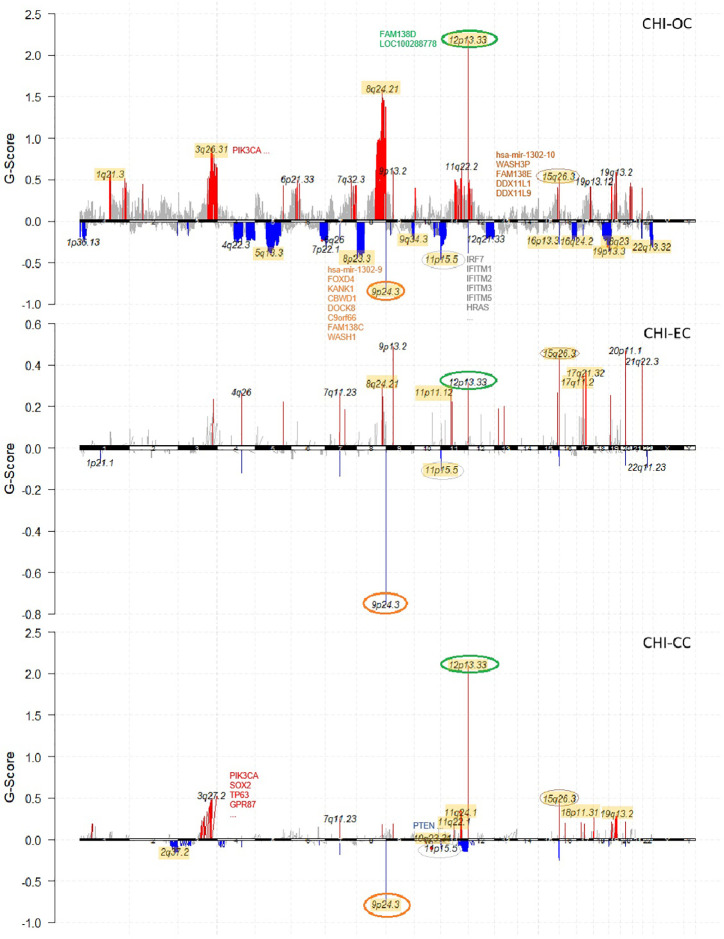
Chromosome plots showing recurrent CNV events identified by Gistic2 in each cancer type (OC, EC, CC) of the studied cohort. Amplifications are colored in red and deletions colored in blue. Common CNVs that occurred in all three cancer types are highlighted with circles. For each cancer type, the results are compared with the corresponding TCGA cohort, and all the overlapping recurrent regions are highlighted in yellow background.